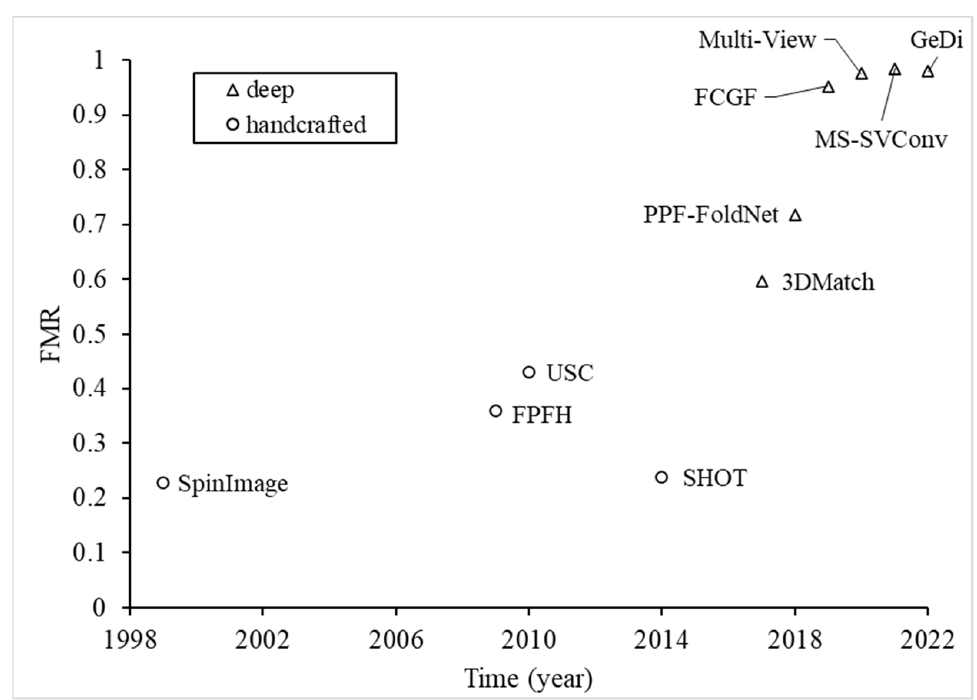
Figure 1. FMR for various representative feature descriptors of different years, based on the 3Dmatch dataset. In an individual year, when multiple deep feature descriptors were proposed, only that with the highest FMR is shown. The presented feature descriptors are SpinImage [19] , FPFH [20] , USC [21] , SHOT [22], 3DMatch [32] , PPF ‐ FoldNet [34] , FCGG [35] , Multi ‐ view [36], MS ‐ SVConv [38] , and GeDi [40] .